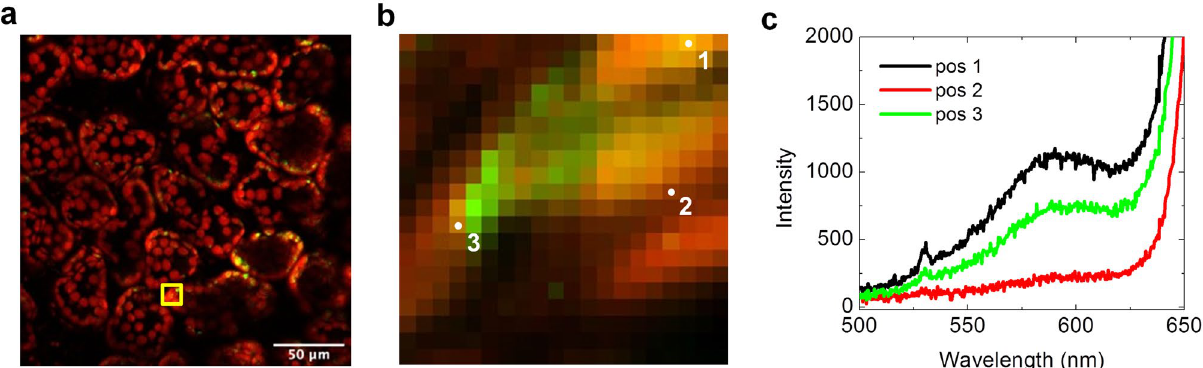
Figure 2. Spectral mapping for a fresh Col-0 leaf. ( a ) TPF (red) and SHG (green) imaging of a fresh intact wild-type Col-0 leaf. ( b ) Spectral mapping of the yellow box area in ( a ), with the total spectral intensity of the